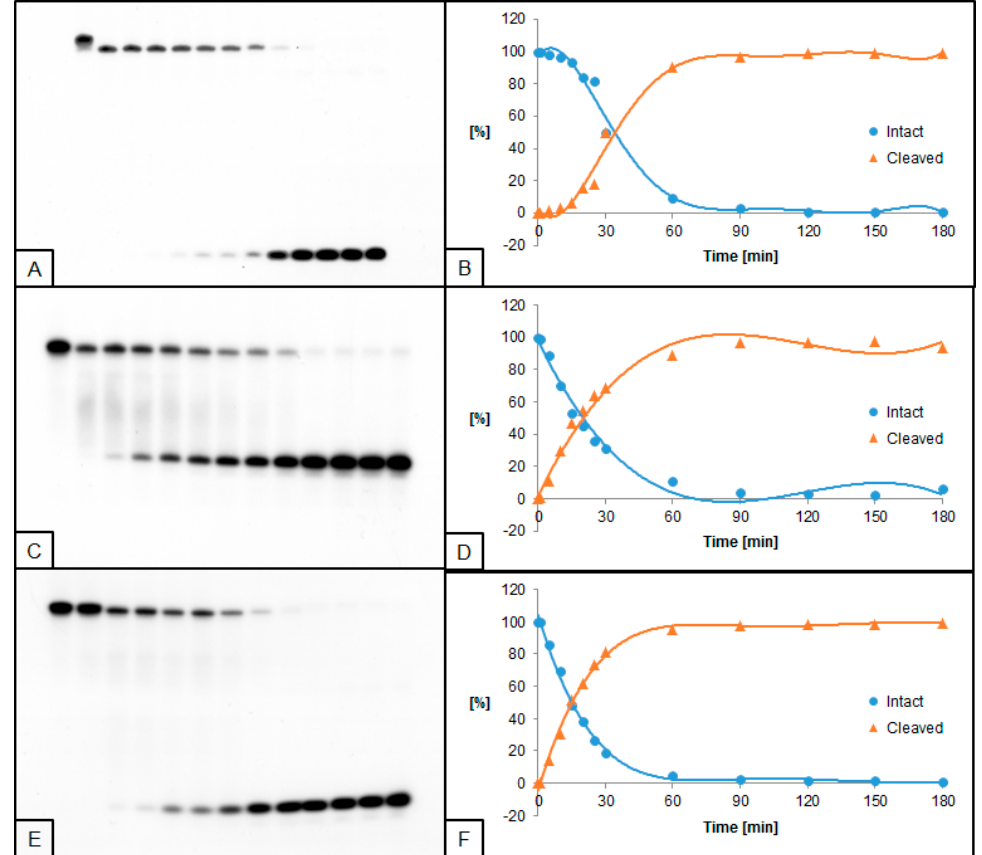
Figure 2. Cleavage of dsDNA containing dU and (5 ′ S ) − 5 ′ ,8-cyclo-2 ′ -deoxyadenosine (ScdA) by 0.5 U UDG and 0.02 U hAPE1. ( A , B ) dU( − 5)ScdA; ( C , D ) dU(+5)ScdA; ( E , F ) dU( − 5)(+5)ScdA. ( A , C , E ) show 13 lanes each, which correspond to reaction times 0, 1, 5, 10, 15, 20, 25, 30, 60, 90, 120, 150, and 180 min starting from the left. ( B , D , F ) show the quantity losses of intact ssDNA (blue) and the quantity increases of SSB-DNA (orange).